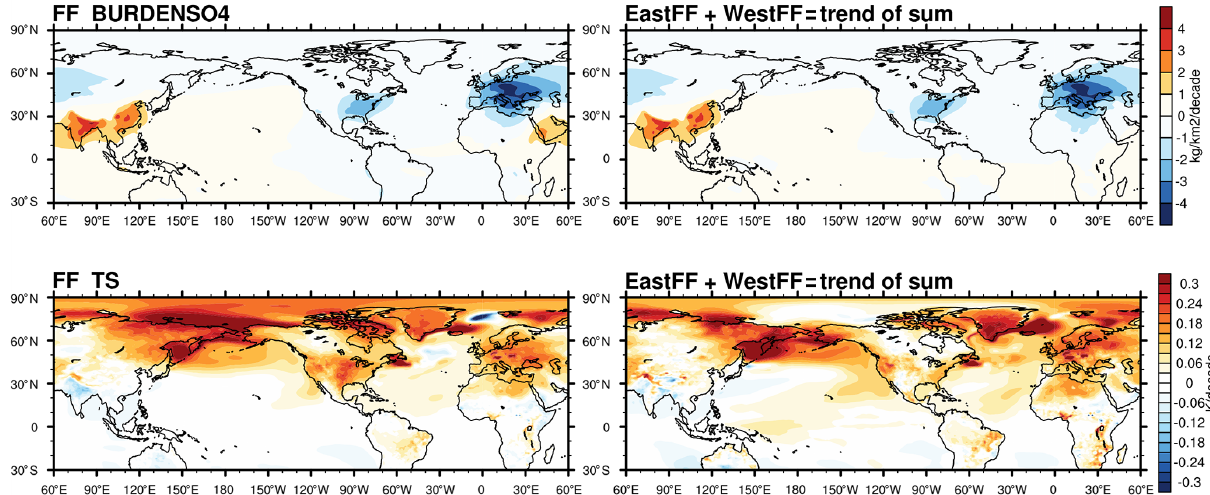
Figure 3. The left column shows the 40-year trend of (top) sulfate column burden (kgkm − 2 per decade) and (bottom) surface air temperature in response to FF forcing from 1980 to 2020. The right column shows the same as the left column but for the summation of EastFF and WestFF, which is obtained by first adding EastFF and WestFF responses together and then calculating the 40-year